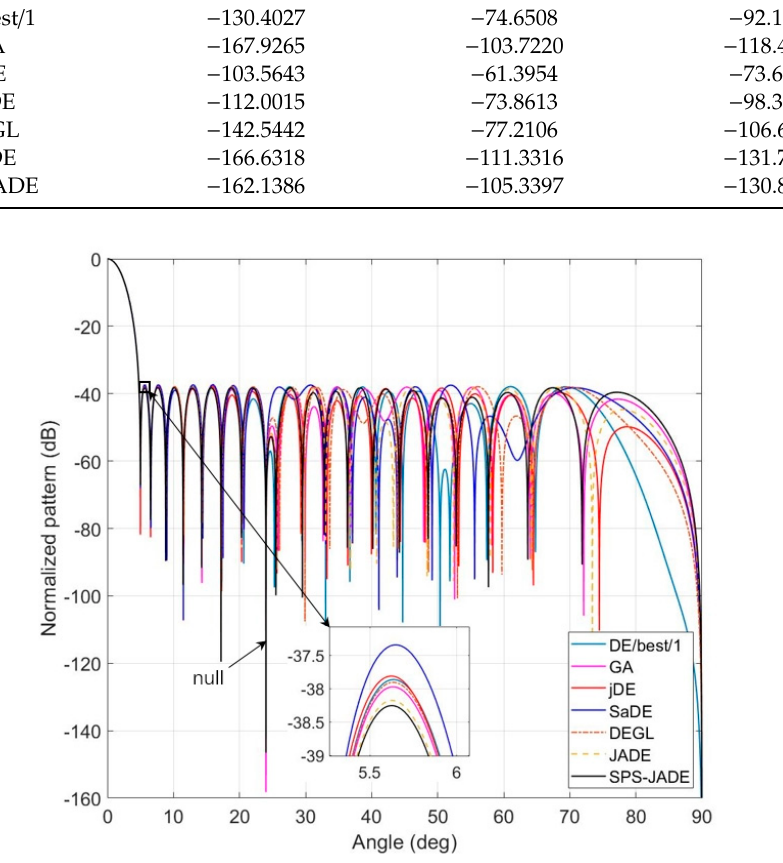
Figure 5. The optimal patterns with the null at θ = 24° for the linear antenna array. Table 6. The optimal excitation amplitudes of array elements computed by SPS-JADE algorithm with sidelobe suppression and null depth.